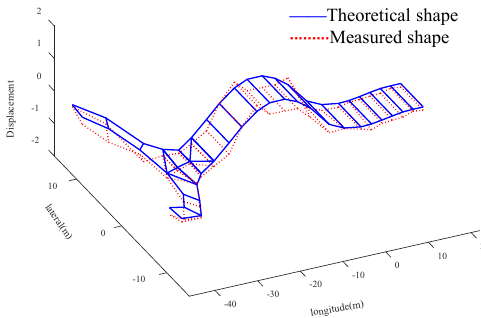
Figure 21. Comparison of the shape of 1st (cid:108) .